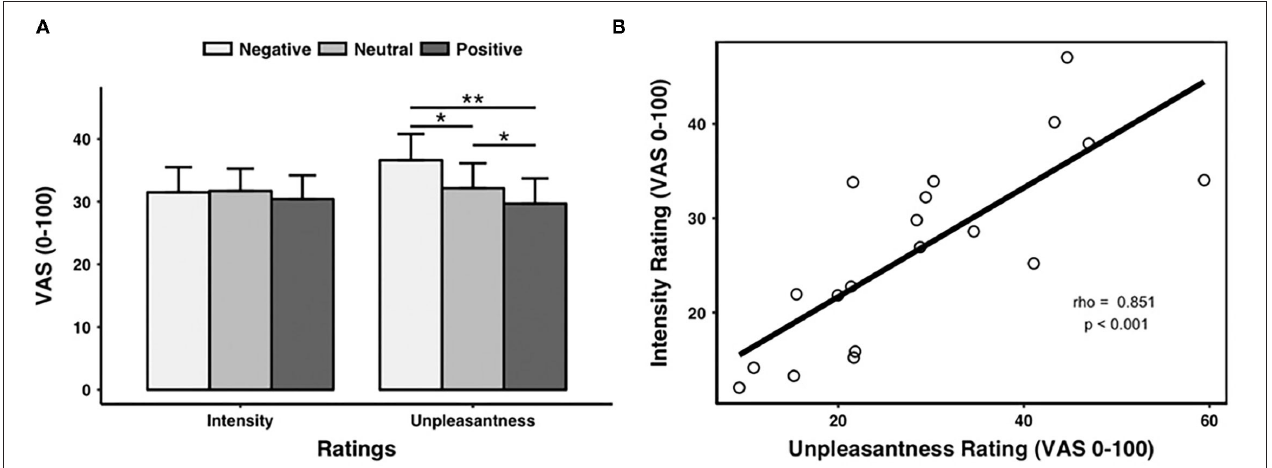
FIGURE 2 | Pain ratings. (A) Ratings of pain intensity and unpleasantness for each prime valence (negative, neutral, and positive). The unpleasantness ratings showed a significant main effect of prime valence, while the intensity ratings did not show a significant main effect of prime valence. (B) Across all the pictures, the averaged intensity ratings were significantly positively correlated with the averaged unpleasantness ratings. VAS, visual analog scale. * p < 0.05, ** p < 0.01. Error bars stand for SEs.